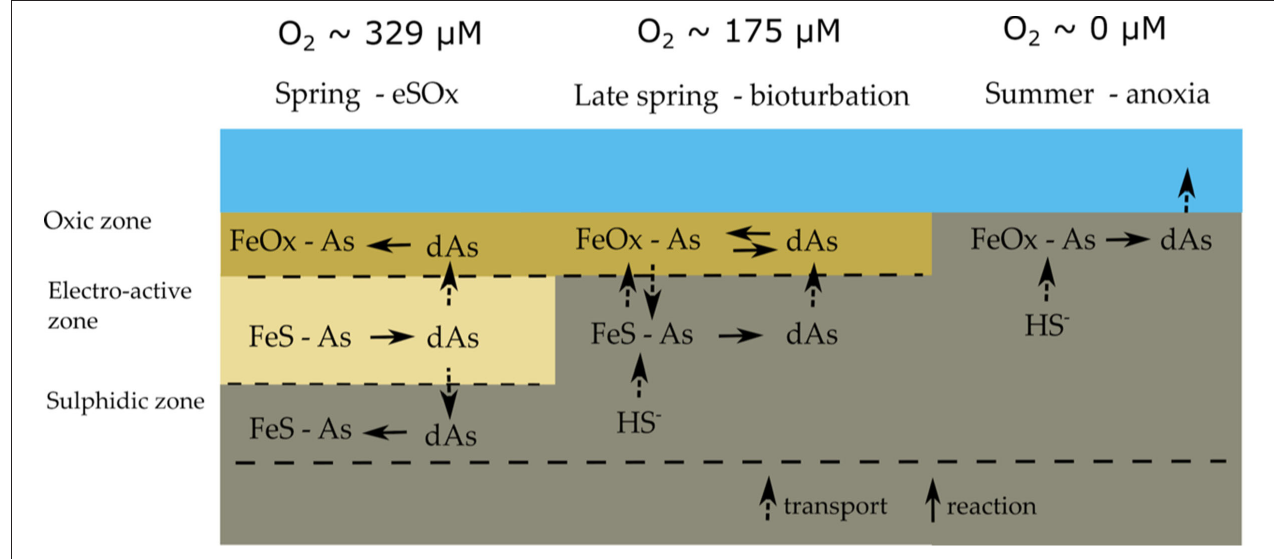
FIGURE 3 | Conceptual model of the sedimentary arsenic cycle in seasonally hypoxic Lake Grevelingen; typical bottom water oxygen concentrations are indicated above. The dominant mode of geochemical cycling alternates between electrogenic sulfur oxidation in spring, bioturbation in late spring and anoxia in summer. See main text for